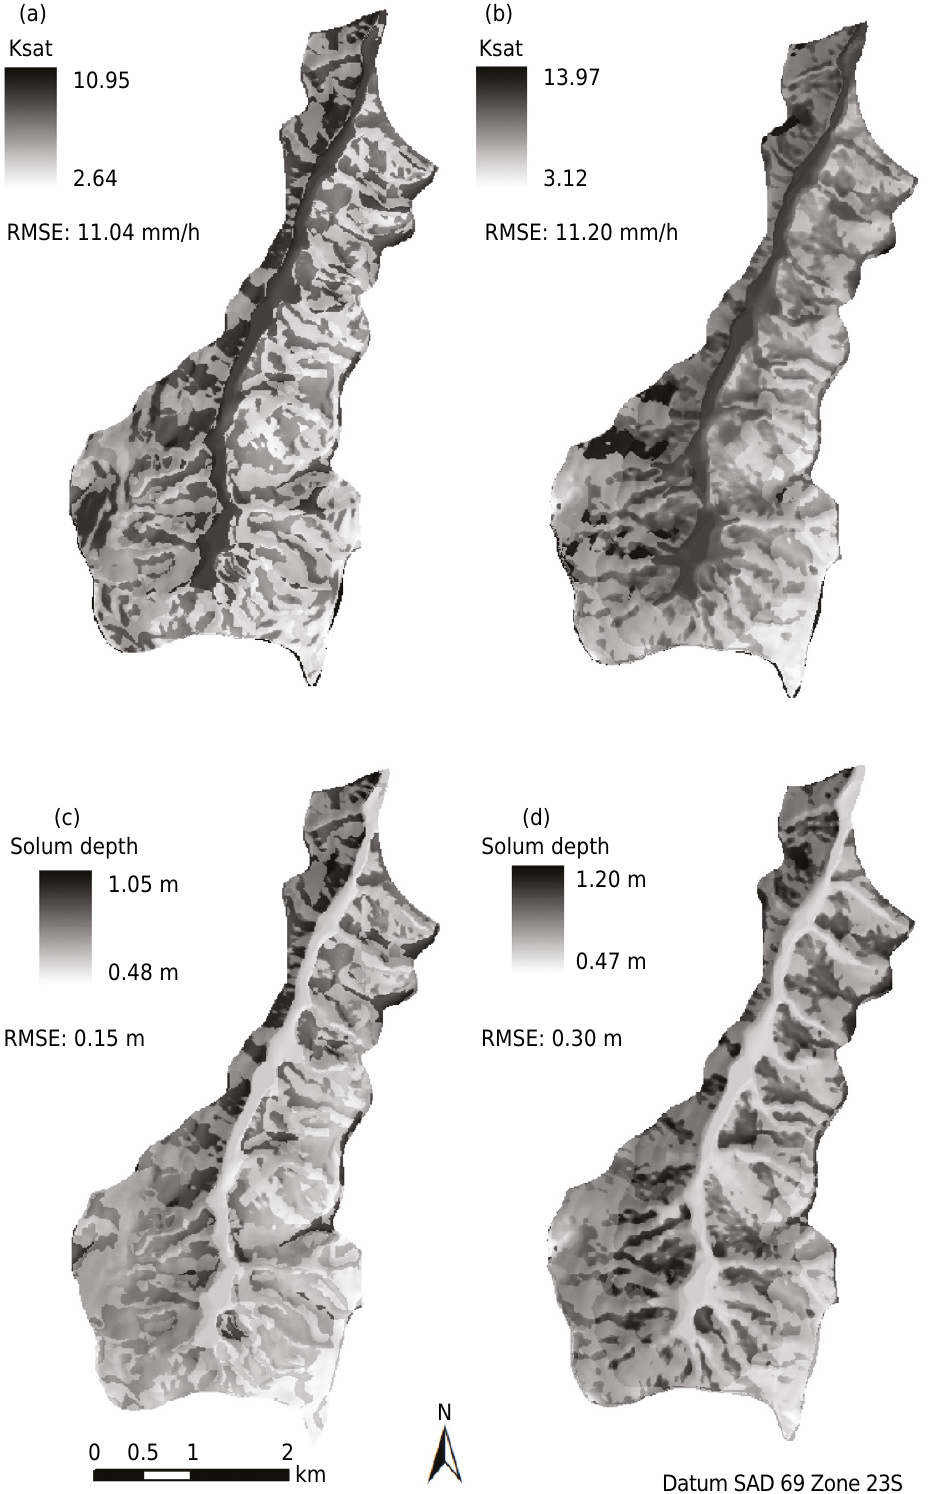
Figure 3. Saturated hydraulic conductivity (Ksat) determined by the GEOM method (a), Ksat determined by the AT method (b), solum depth (PROF) determined by the GEOM method (c) and PROF determined by the TA method (d) in the Posses watershed, Extrema,